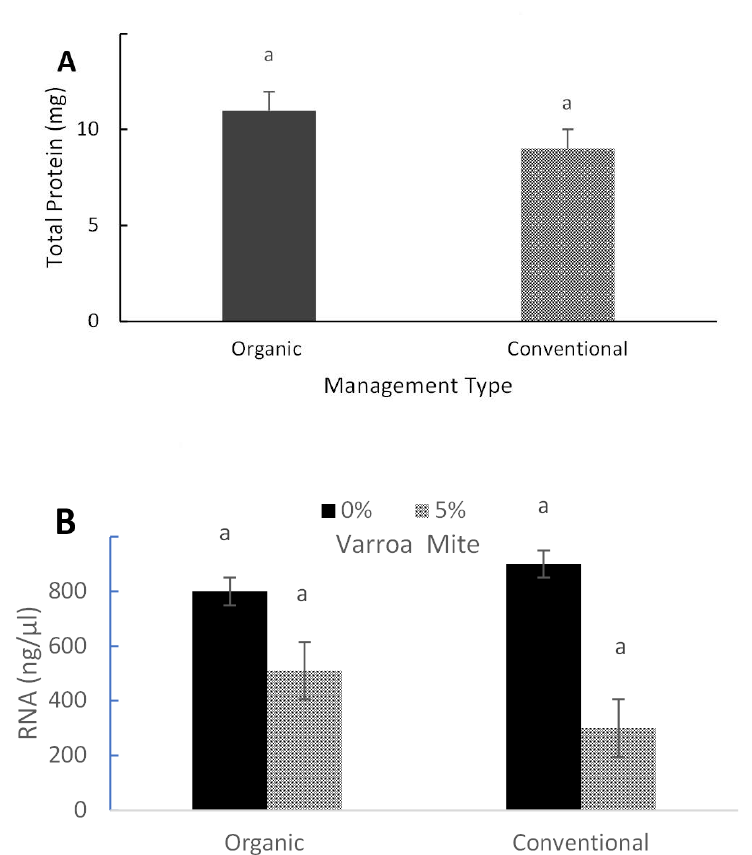
Figure 1. Protein in young adult bees from organically and conventionally managed apiaries. Data on the total soluble protein content of adult bees between the two beekeeping practices were pooled. ( A ) Mean (±SE) total soluble protein and ( B ) mean total RNA compared by Varroa mite infestation levels. Different letters above bars indicate treatment differences ( p < 0.05, Tukey’s test).